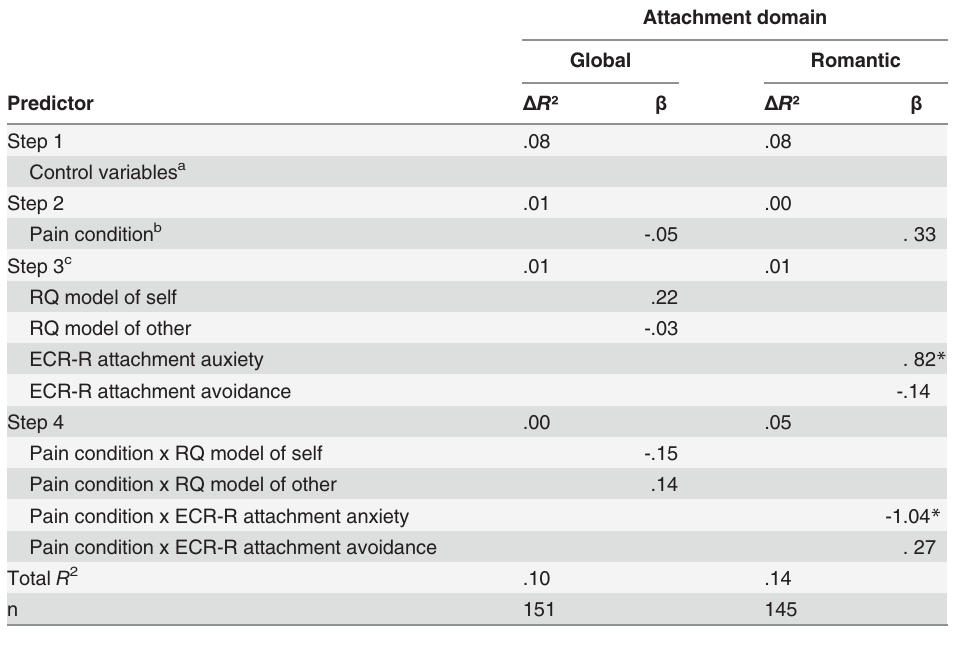
Table 5. Regression analyses predicting pain intensity from pain condition, attachment dimensions, and interaction between pain condition and attachment